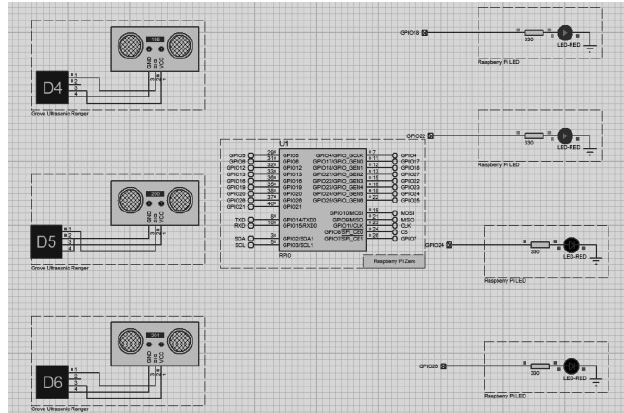
Fig. 8. Simulated